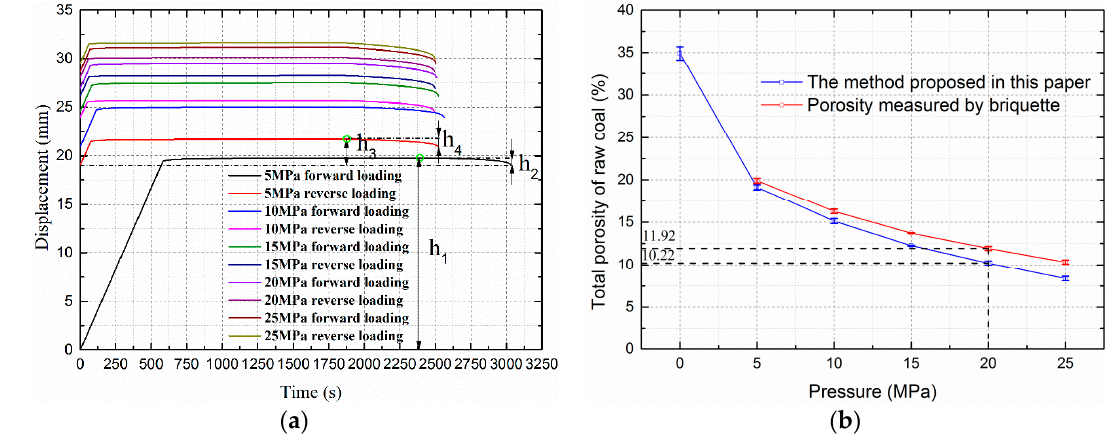
Figure 12. ( a ) Time–displacement curves determined during loading and unloading; and ( b ) comparison of porosity differences between the method of compressing briquette and then testing porosity and the method proposed in this paper.